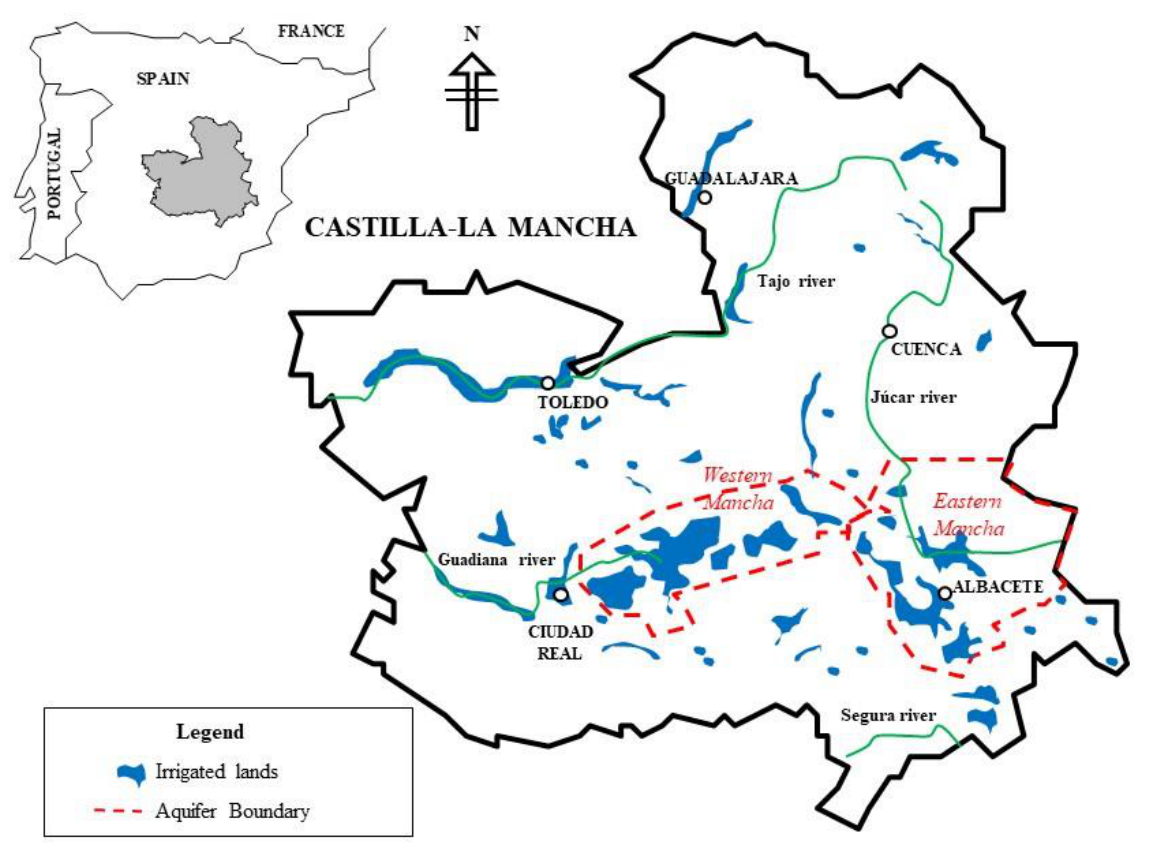
Figure 1. Distribution of the irrigated lands in Castilla-La Mancha.